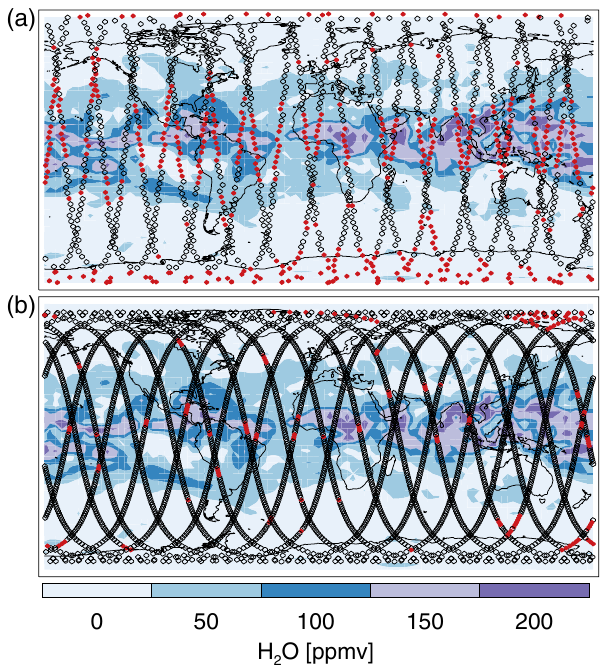
Figure 1. Typical MIPAS (a) and MLS (b) sampling overlaid on top of a modelled water vapour map (1 June 2005) at 200hPa. Red dots show missed or failed retrievals: in the tropics, these are mostly due to